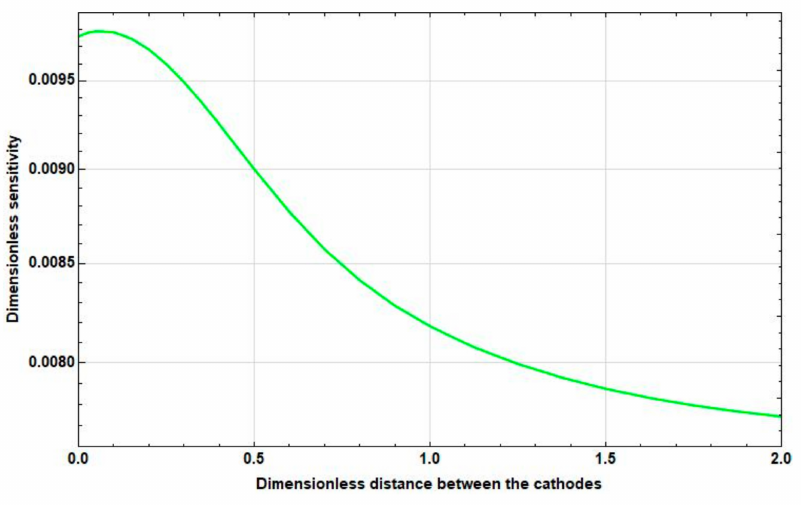
Figure 7. Dependence of the sensitivity on the intercathode distance at ˜ f = 0.5.